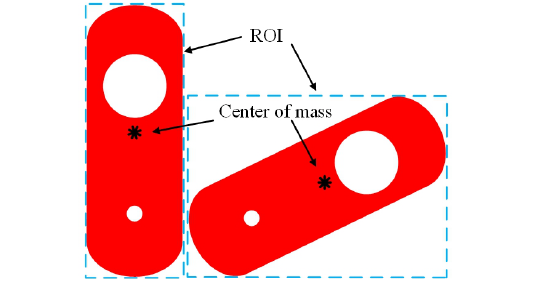
Figure 9. Schematic of ROI selection with the minimum external rectangle.